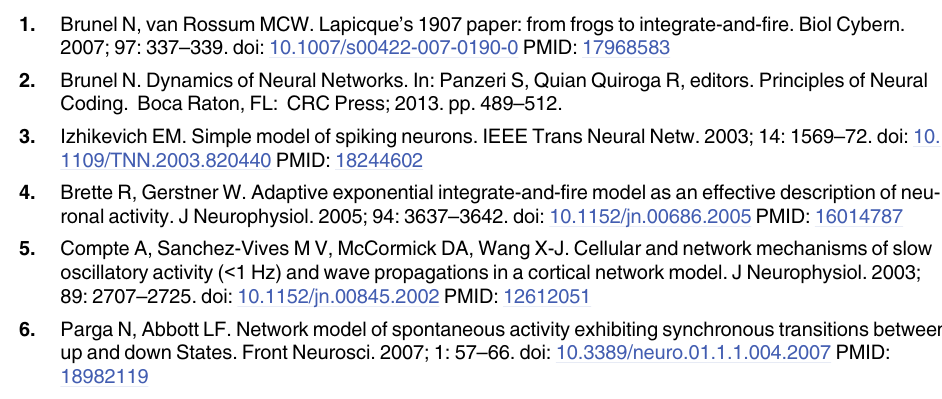
S1 Fig. Calibration of morphology of multi-compartmental models. (A) Layer 2/3 pyrami- dal cells: Comparison of amount of cellular membrane surface between anatomically recon- structed cells (left) and synthetic morphologies (right). Results shown in units of μ m 2 per cell for 25 μ m bins of cortical depth. Green lines indicate profiles of individual cells and black lines are average traces. (B) As in panel A, but for stellate cells. S2 Fig. Summary of all tested proxies in the reference case. (A) Fraction of LFP variance explained by the different proxies at different depths. FR: Firing rate; Vm: membrane potential; AMPA/GABA: input current values; ∑ I: sum of the two input currents; ∑ |I|: sum of the absolute values of the two input currents. Quantities with _exc/_inh subscript are computed only over the set of excitatory/inhibitory neurons, e.g., AMPA_exc is the average AMPA current input into excitatory neurons. Quantities with no subscript are computed over all neurons. (B) Opti- mal time lag for different depths for same proxies as previous panel. (C) Fraction of variance explained by combination of AMPA and GABA currents with same coefficients as Eq (4) and different delays. Optimal (and reference) combination is indicated by an X. S3 Fig. Bayesian information criterion. Same as panel 5C but showing for each proxy the BIC value (see Methods) instead of the fraction of variance explained. S4 Fig. Input modulation with real morphologies. Same as Fig 6B and 6D when using real reconstructed morphologies of cortical stellate and layer 2/3 pyramidal cells (see Methods).